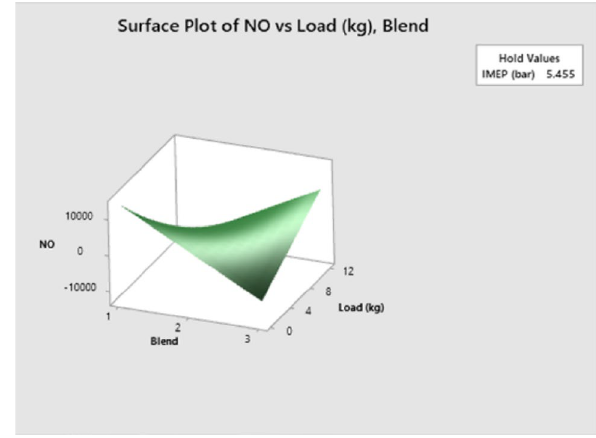
with nanoparticles 2